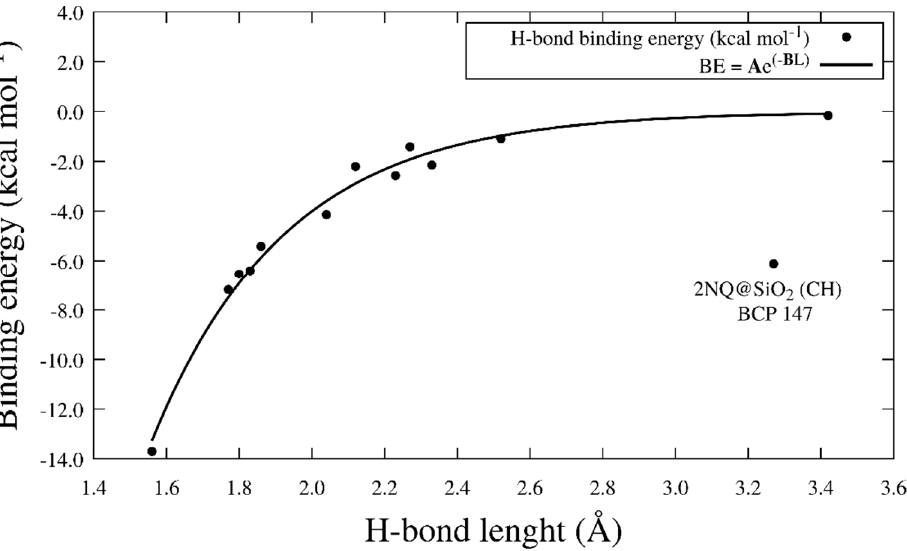
Figure 9. H − bond length and BE